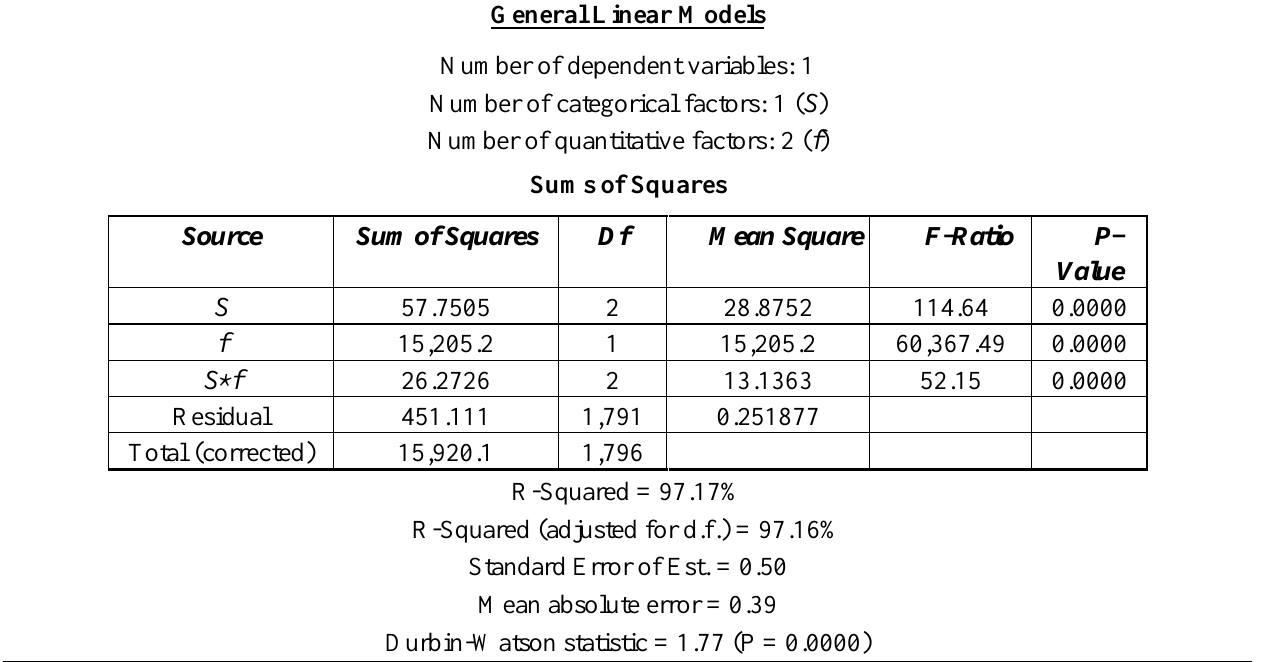
Table 6. Resulting ANOVA table of the image sequence sensor noise model for a Foveon X3 sensor (dynamic range 2 12 raw